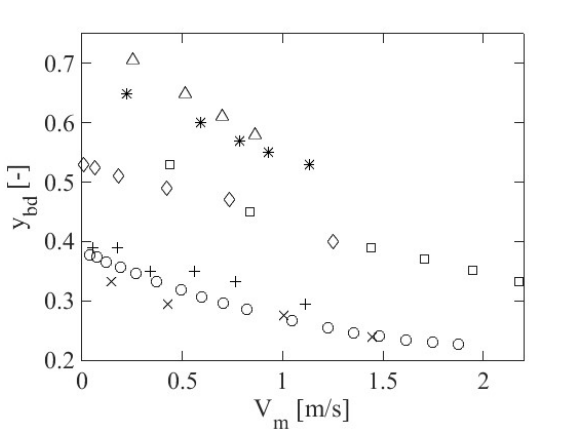
Fig. 2. Measured values of the sliding bed layer thickness y bd